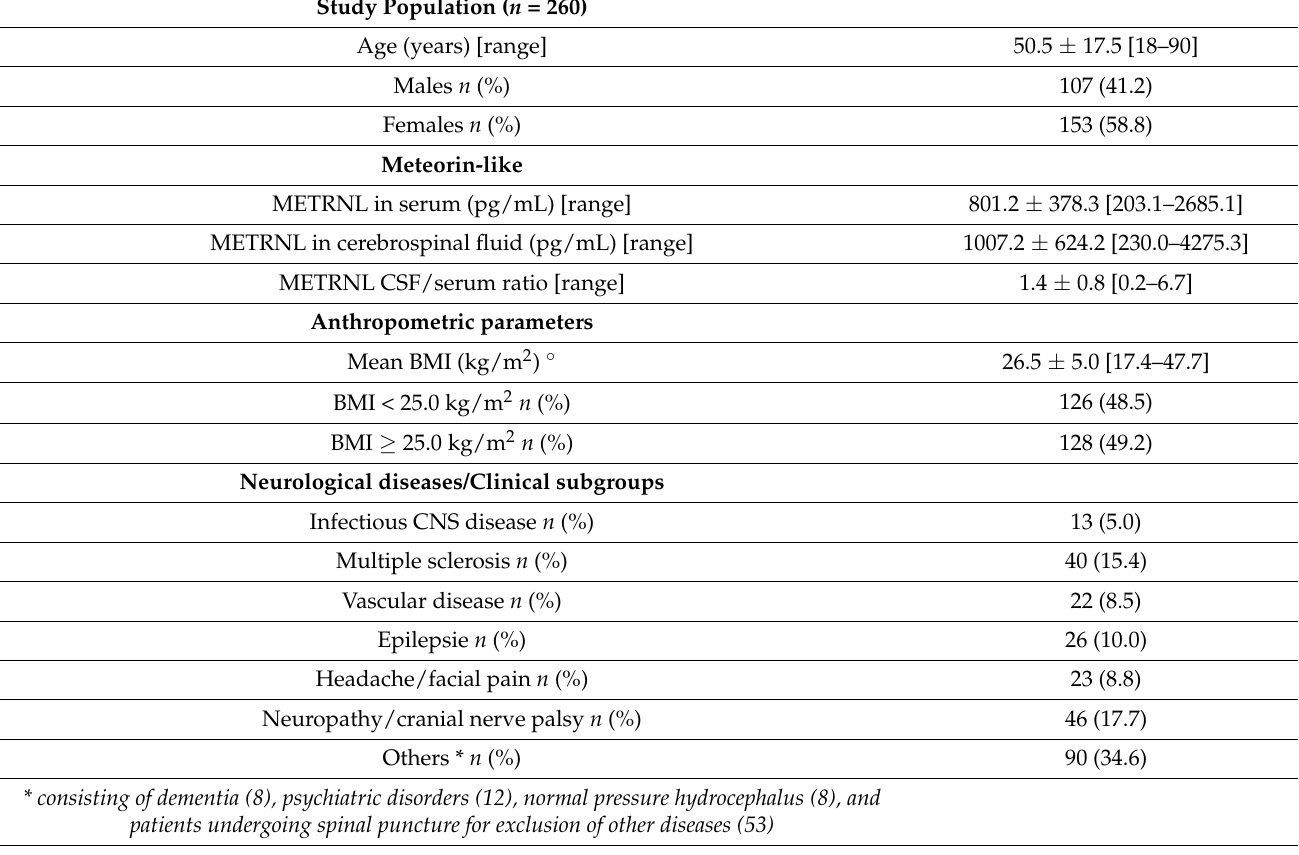
Table 1. Characteristics of the study population ( n = 260 individuals). Anthropometric and laboratory parameters in serum and CSF (cerebrospinal fluid) are shown. General patient characteristics have been published earlier by our group in several studies on the role of classical adipokines in CSF (1, 6–8). Mean values + standard deviation (SD) and range are given for numerical parameters. For classified variables, absolute numbers and percentages are shown. The p values were calculated by using the Mann–Whitney U test for two subgroups (* p < 0.05). BMI, body mass index; CSF, cerebrospinal fluid; CNS, central nervous system; METRNL, Meteorin-like.